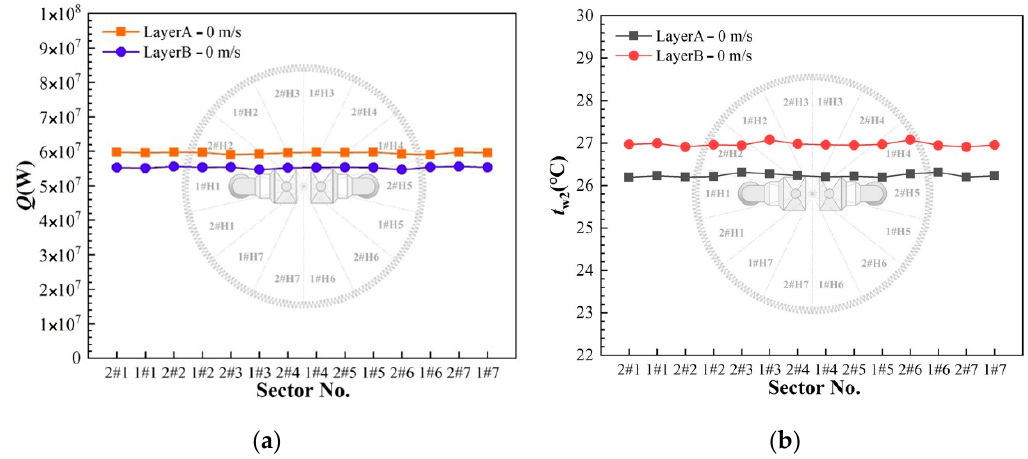
Figure 9. Heat rejections and water outlet temperatures of double-layer sectors in the absence of wind in the case of 2 units. ( a ) Heat rejections; ( b ) water outlet temperatures.